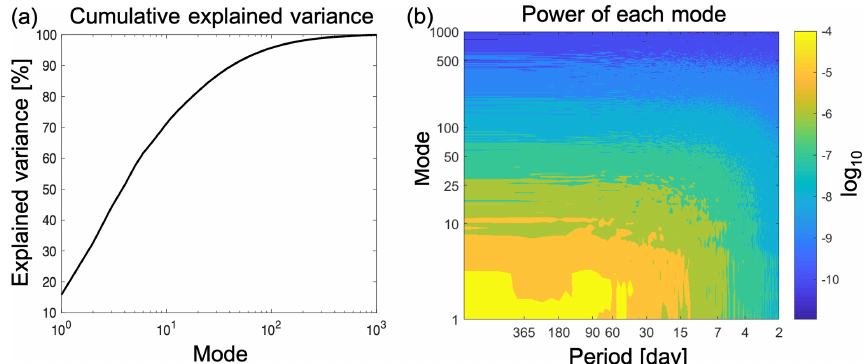
Figure A1. (a) The cumulative explained variance of the first 1000 EOF modes of PV. (b) The power spectrum of the first 1000 EOF